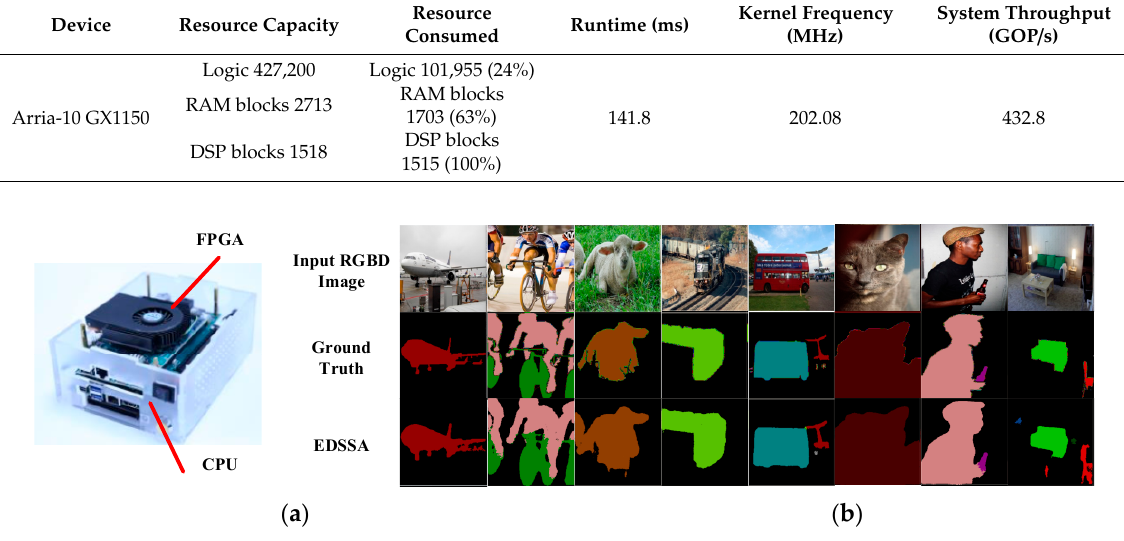
Figure 9. Platform and semantic segmentation result samples. ( a ) HERO [32]; ( b ) result. Table 3. Comparison with other platforms with Table 2. Summary of EDSSA with best parallelism.